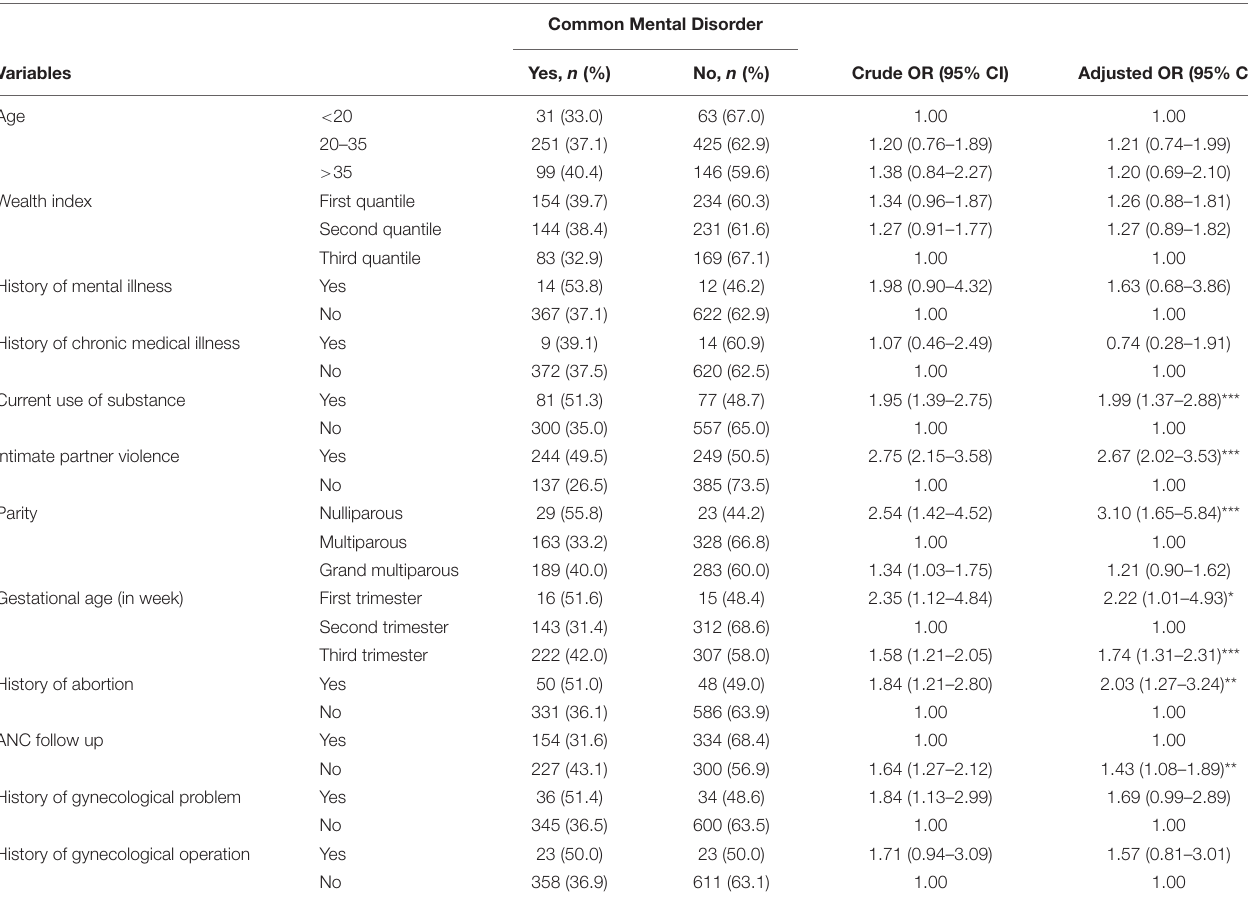
TABLE 3 | Results of bivariate and multivariate analysis for factors associated with antenatal common mental disorders. Common Mental